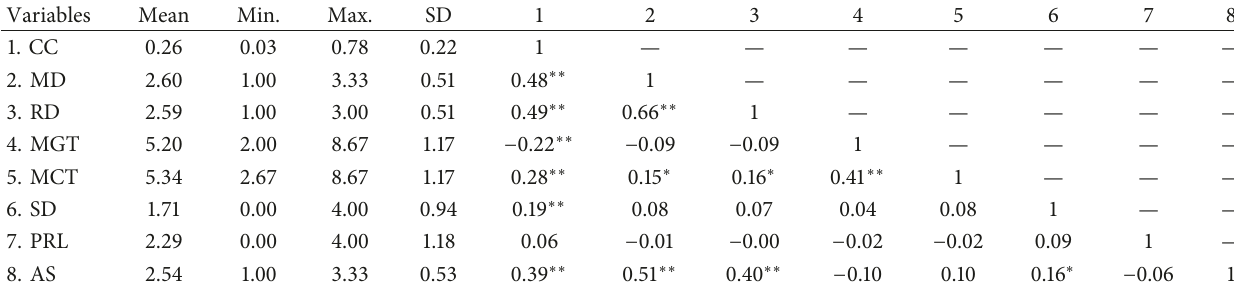
Table 1: Descriptive statistics and correlations.